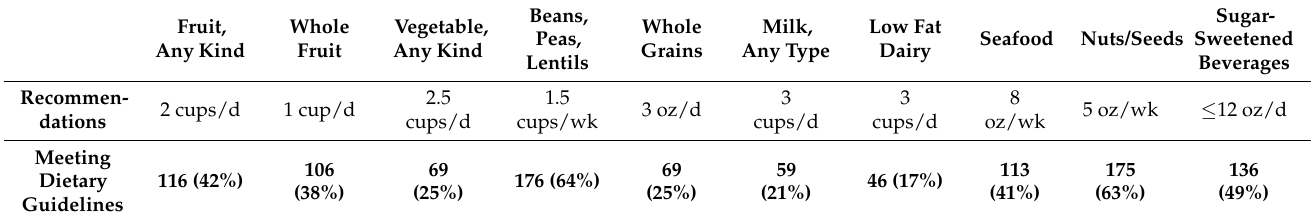
Table 3. Frequency of participants (n = 276) who meet the U.S. Dietary Guidelines [43] food group or component recommendations